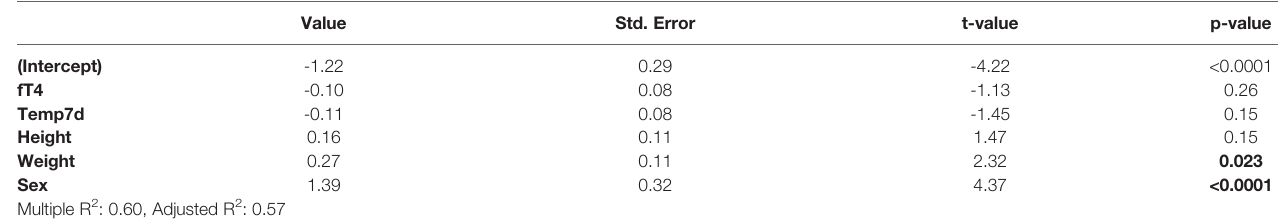
TABLE 2 | Results of multiple linear regression.